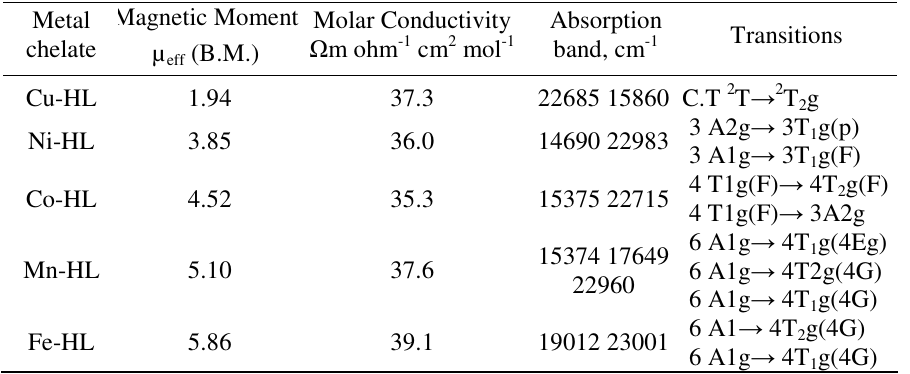
Absorption Transitions band, cm -1 g 2